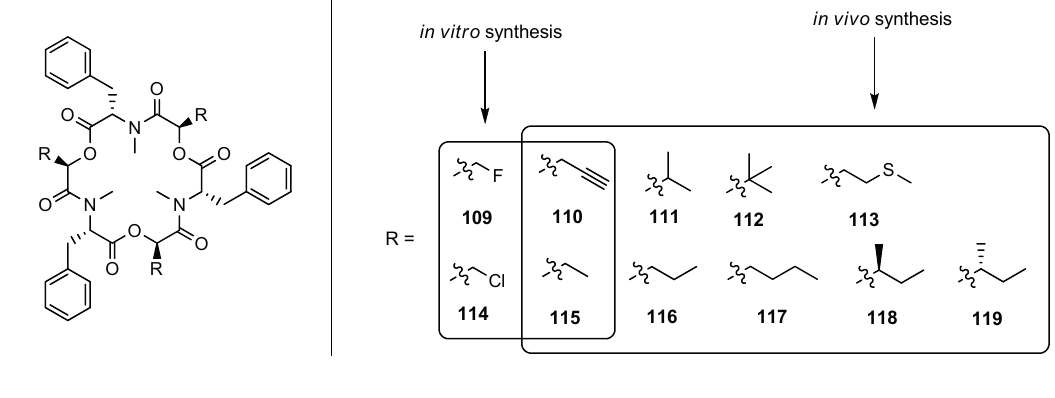
Figure 10. In vitro and in vivo synthesis of beauvericin analogues 109 – 119 .